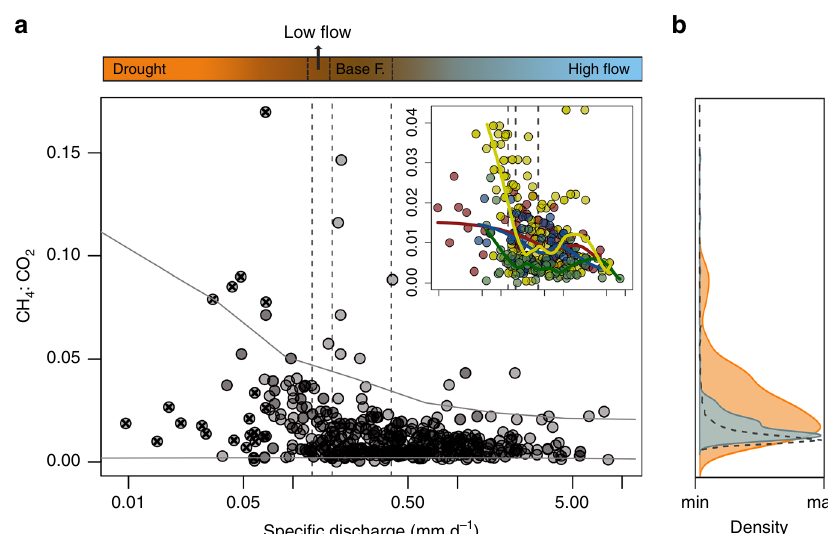
Fig. 6 Drought promotes anaerobic signals in boreal headwater streams. a Relationship between speci fi c discharge (mm d − 1 ) and the molar ratio between CH 4 and CO 2 in the surface water of fi ve headwater streams of the KCS (i.e., stream order 1 or 2; catchment area < 1.5 km 2 ; n = 5; Supplementary Fig. 1a, Table 1) during the summer period between January 2010 and October 2018. Observations with asterisks correspond to the 2018 drought. Vertical dashed bars represent thresholds among fl ow conditions during this period. Discharge delineation is based on percentile distributions of the historical (1980 – 2018) records in the catchment: drought (0th – 10th percentile; n = 59), low fl ow (10th – 20th percentile; n = 22), base fl ow (20th − 50th percentile; n = 90), and high fl ow (50th – 100th percentile; n = 193). Gray lines are the nonparametric 10th and 90th percentile regression based on all of the data. The inset shows locally weighted regression model lines (Loess) for each headwater stream. b Density distributions for CH 4 :CO 2 during drought (orange) and nondrought (blue) hydrological conditions. The dashed line represents the density distribution of stream CH 4 :CO 2 from seven additional headwater catchments in northern Sweden sampled before the summer 2018 severe drought (site locations in Supplementary Fig. 1a) 50